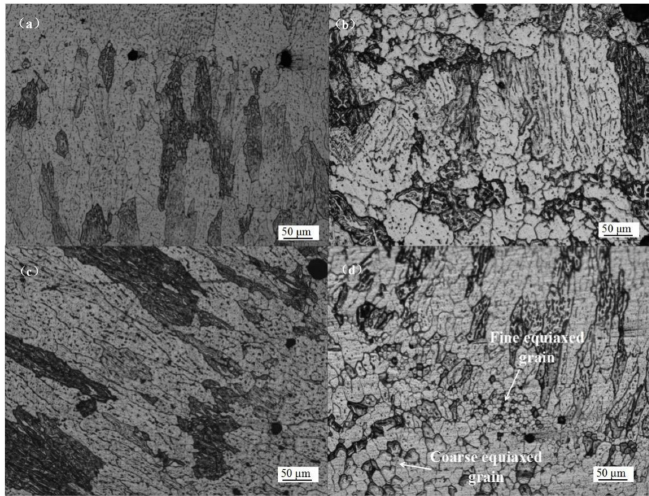
Figure 8. Microstructure of the WAAM 2219 alloys using different modes: ( a ) CMT; ( b ) CMT-ADV; ( c ) CMT-P, and ( d )